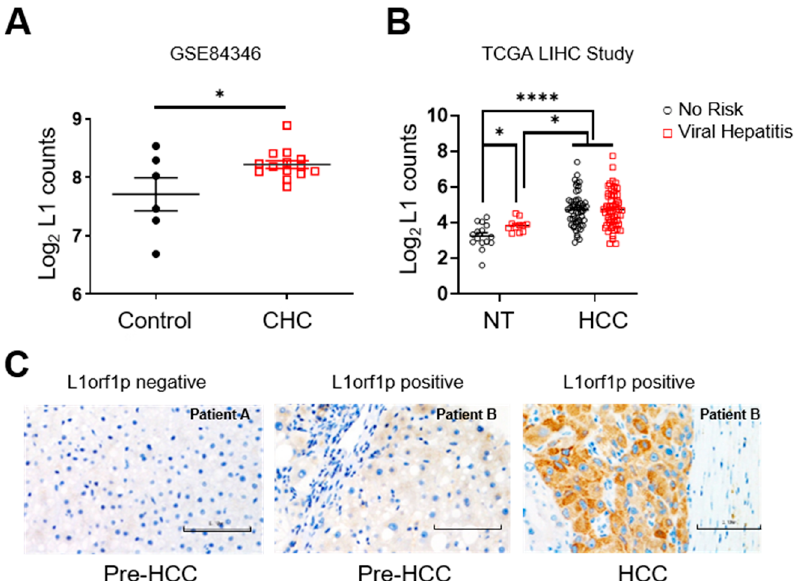
Figure 1. HCV activates L1 expression in non-tumour livers. Graphs represent normalised L1 tran- script counts in the liver of chronically infected HCV patients versus the healthy volunteer control group ( A ), in the non-tumour liver and HCC tissue of HCC patients with indicated aetiologies; no risk = no history of any known HCC risk factors ( B ). Representative L1orf1p IHC images of CHC patient liver biopsies pre-HCC and HCC, where blue represents hematoxylin stained nuclei and brown staining is representative of presence of L1orf1p. Scale bar represents 0.1 mm ( C ). * p < 0.05, **** p < 0.0001, unpaired t -test ( A ) and two-way ANOVA ( B ). Key: CHC = Chronic Hepatitis C pa- tients; NT = Non Tumour; TCGA = The Cancer Genome Atlas; LIHC = Liver Hepatocellular Carci- noma; HCC = Hepatocellular Carcinoma; HCV = Hepatitis C Virus; L1 = Long interspersed repeat element 1; L1orf1p = L1 open reading frame 1 encoded protein.